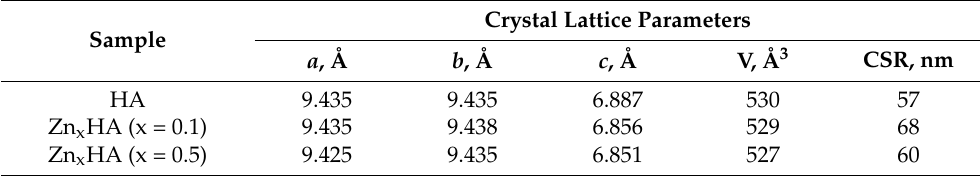
Figure 1. The structure of hydroxyapatite and possible localization of the incorporation of zinc into the crystal lattice. Table 1. Parameters, unit cell volume, and coherent scattering region of Zn x HA samples according to XRD data.